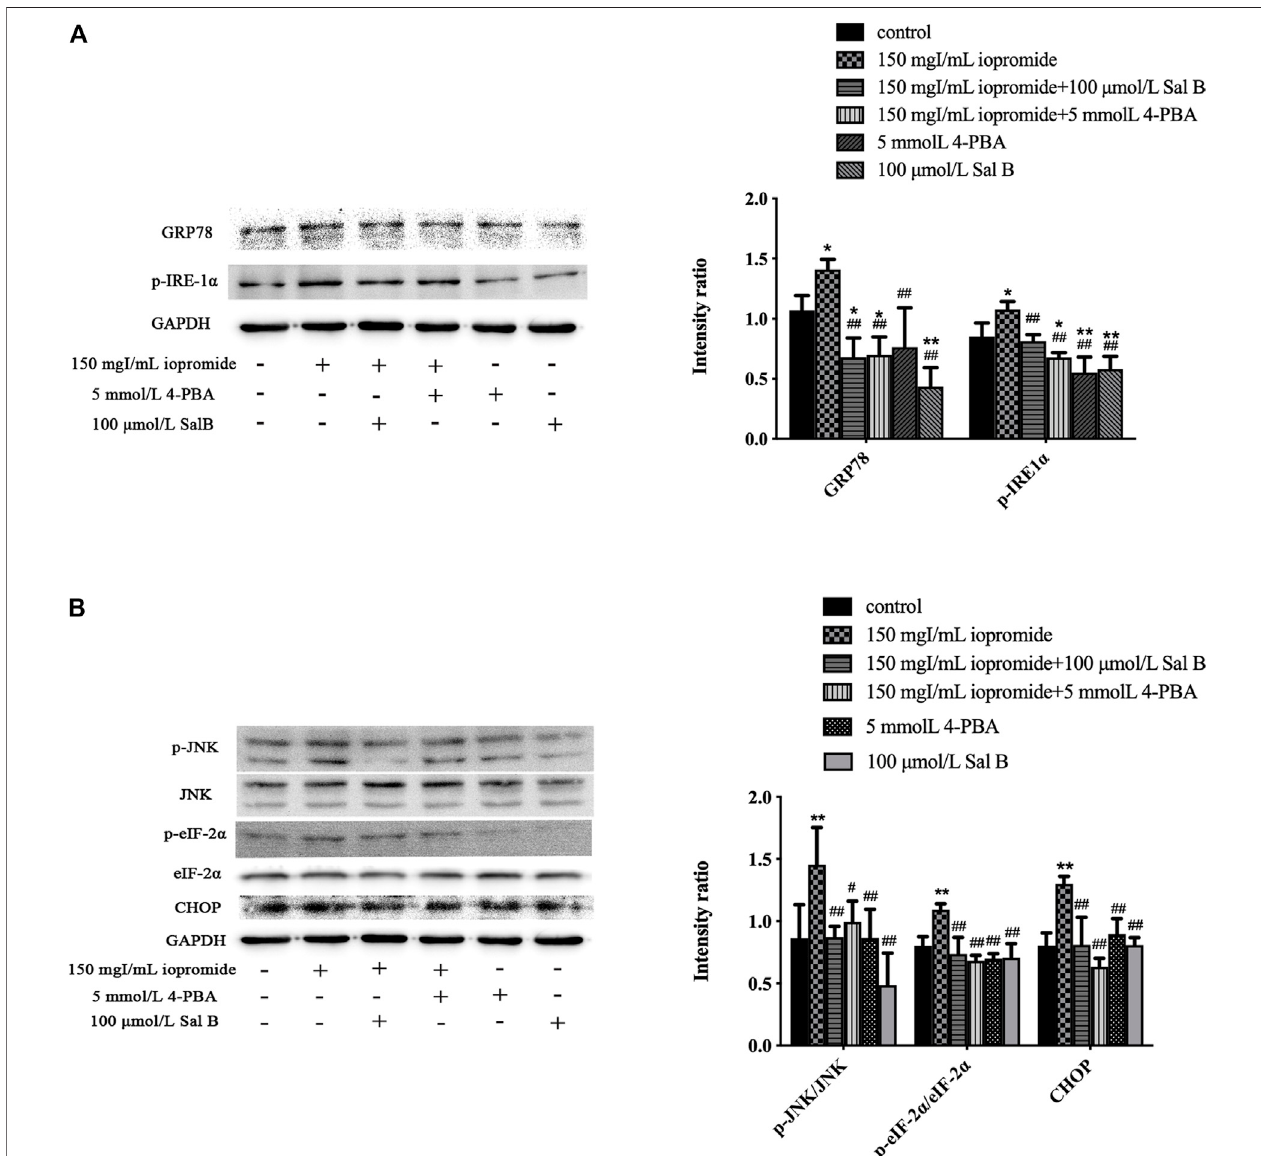
FIGURE6| SalBor4-PBAsigni fi cantlyreducedthelevelofERS-relatedproteinsinducedbyiopromide. (A) SalBor4-PBAreducedthelevelofGRP78andp-IRE- 1 α . (B) SalBor4-PBAdecreasedthelevelsofp-JNK/JNK,p-eIF-2 α /eIF-2 α ,andCHOP.ThedataweredeterminedbyANOVAandLSDpost-hoctestandarepresented as the mean ± SD ( n (cid:1) 3). * P < 0.05, ** P < 0.01 vs. control group; # P < 0.05, ## P < 0.01 vs. iopromide group.